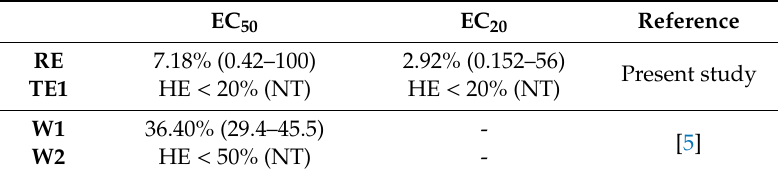
Table 3. Values of EC 50 and EC 20 for bioluminescence inhibition of A. fischeri , expressed in e ffl uent percentage, and the corresponding 95% confidence intervals (CI95) for the treated e ffl uent 1 (TE1) and the raw e ffl uent